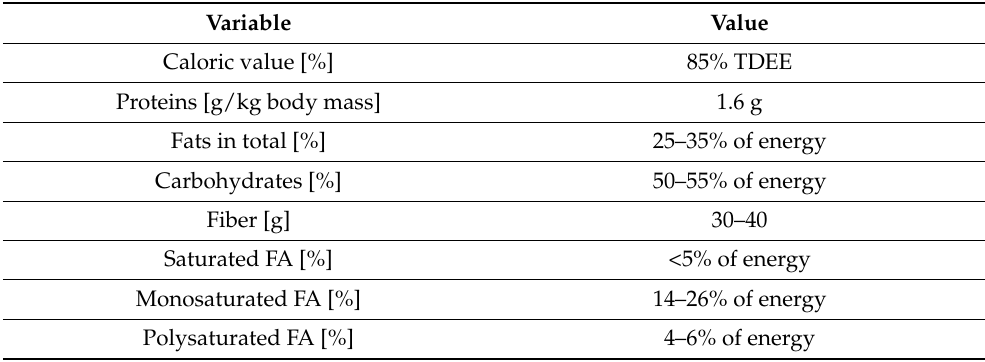
Table 1. General characteristic of interventional